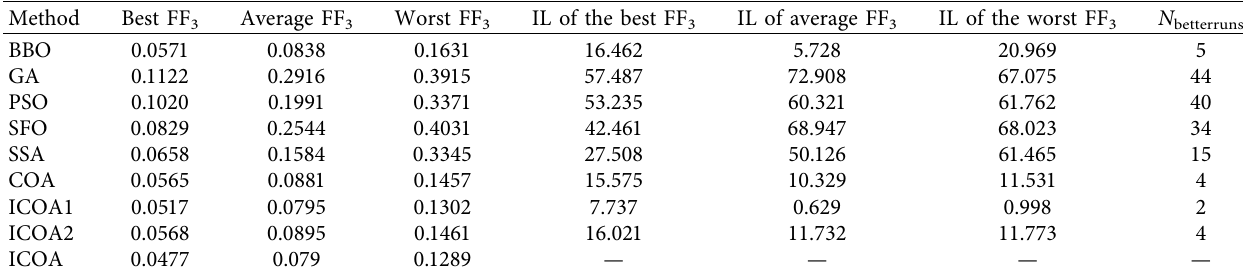
Table 14: The comparison among nine methods of the IEEE 69-bus distribution network for the third case. Method